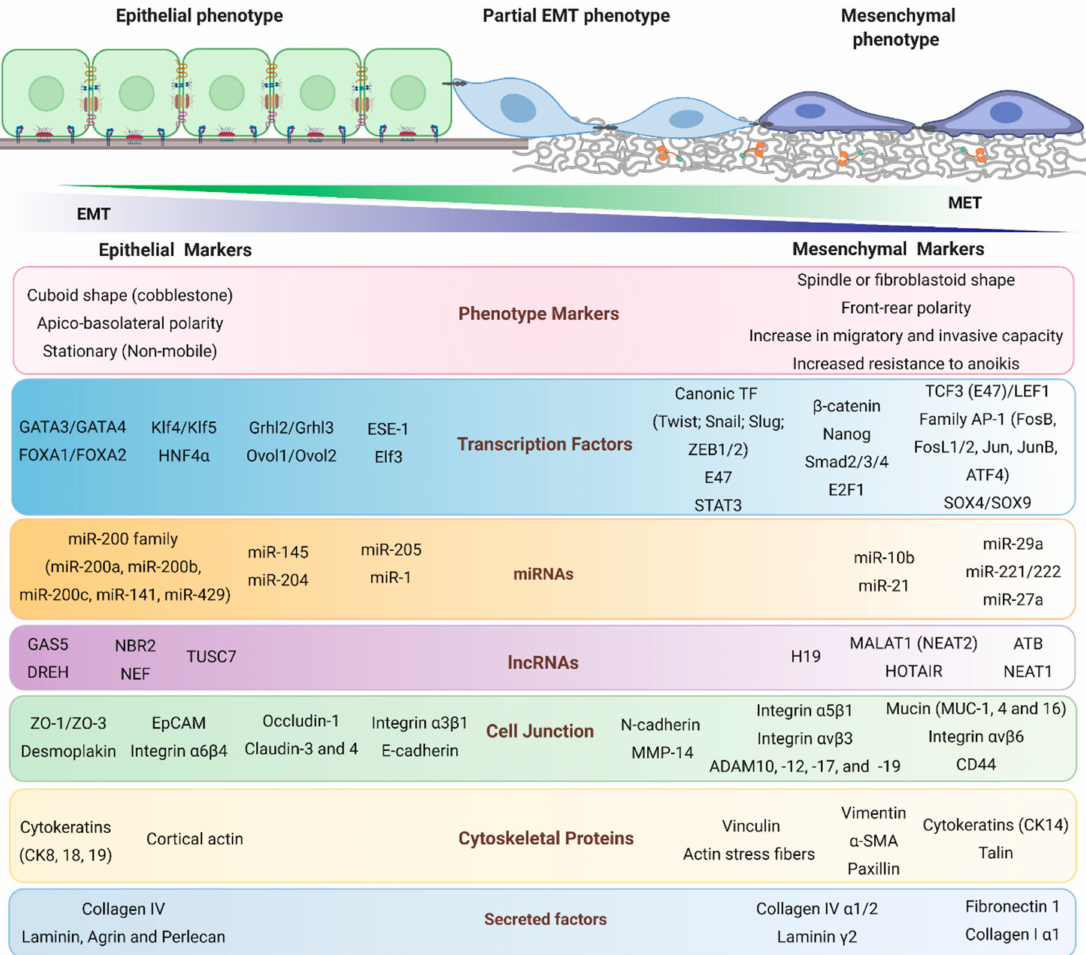
Figure 1. Biological markers of the epithelial–mesenchymal transition in cancer. The epithelial cells lose the cuboid nature and apico-basolateral polarity, acquiring a spindle shape and front–rear polarity; also, the mesenchymal cells acquire the ability to migrate and invade surrounding and distal tissues. Changesin adhesion molecules such as ZO (zonula occludens), occludins, cadherins, mucin, and cytoskeletal proteins such as cytokeratins, occur; also, specific TFs are activated, such as Snail, Twist, and Slug. In addition, epigenetically, each phenotype is regulated by specific miRNAs and IncRNAs. These mesenchymal markers have been associated with tumor